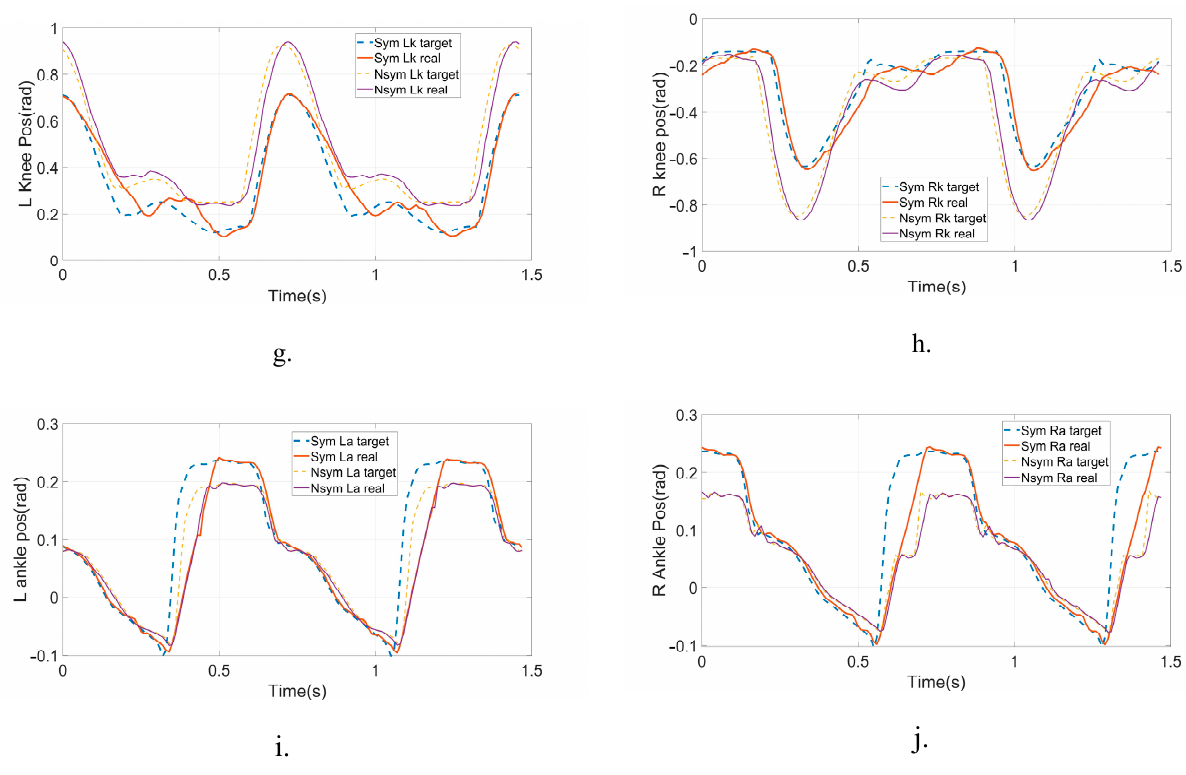
i. j. Figure 8. The positions and tracking performance of each active joint for two steps. ( a ) Left Hip Roll tracking performance. ( b ) Right Hip Roll tracking performance. ( c ) Left Hip Roll tracking performance. ( d ) Right Hip Roll tracking performance. ( e ) Left Hip Pitch tracking performance. ( f ) Right Hip Pitch tracking performance. ( g ) Left Knee tracking performance. ( h ) Left Knee tracking performance.( i ) Left Ankle tracking performance. ( j ) Right Ankle tracking performance.